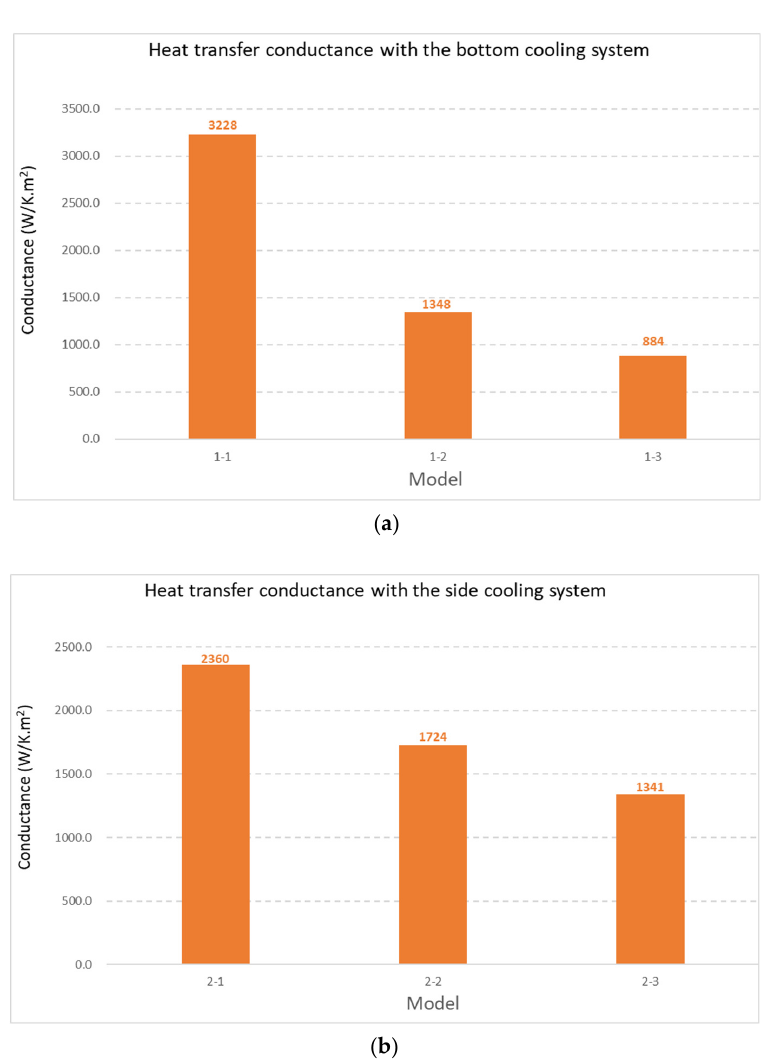
Figure 12. Max temperature and the temperature difference for the bottom ( a ) and side ( b ) cooling sys- tem.